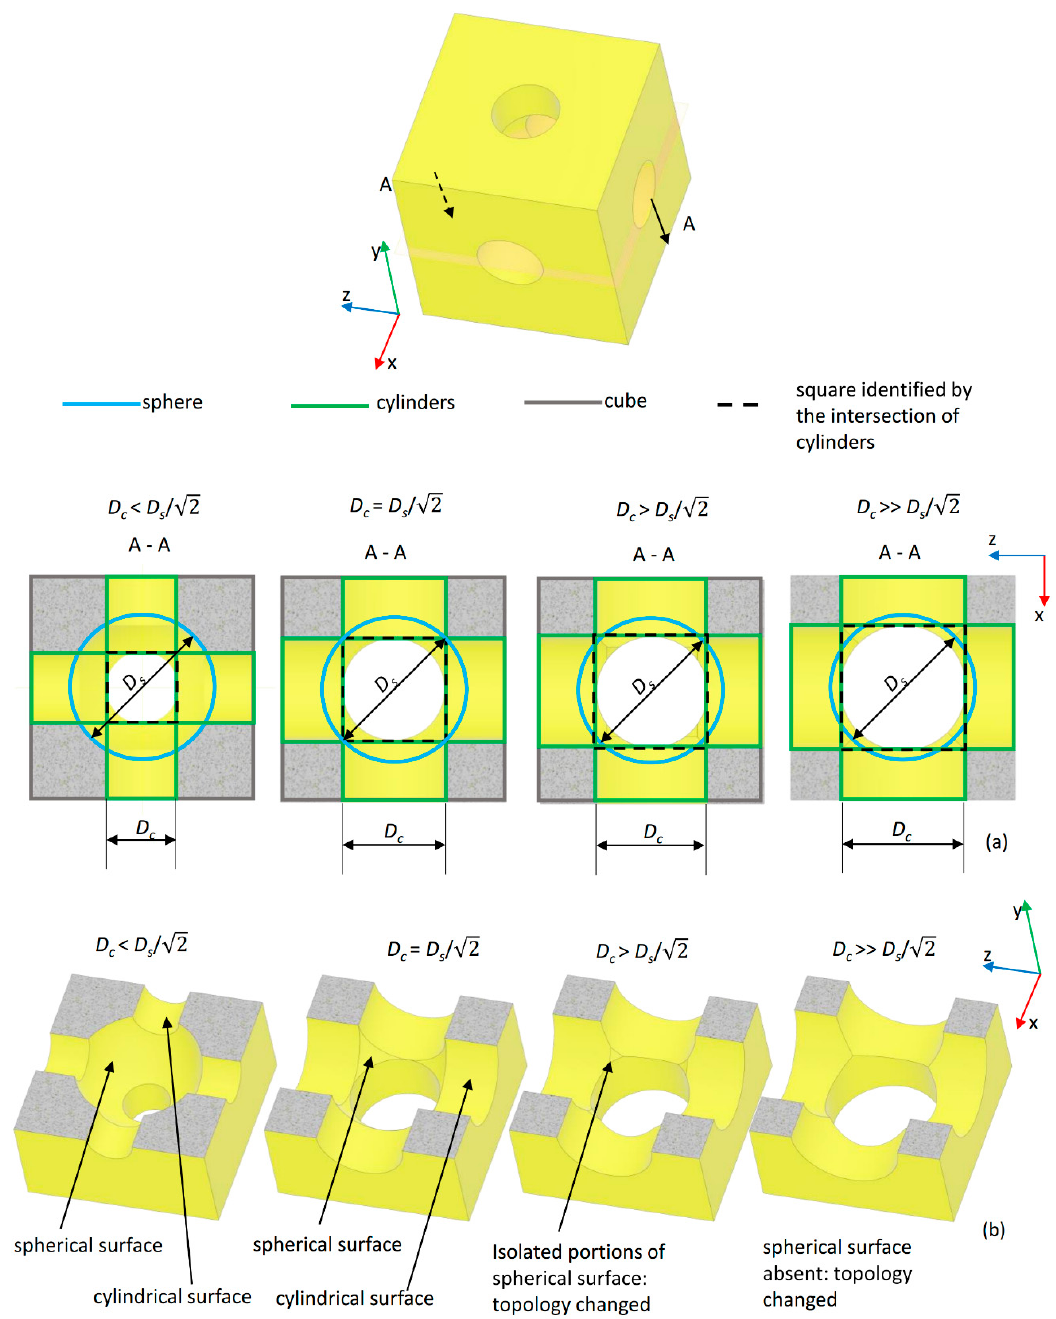
Figure 3. ( a ) Section views—in the plane x–z—of the scaffold unit cell (topology (S) with indicated edges of the primitives (cube, cylinders, and sphere) utilized. When the square obtained by the intersection of the cylinders touches with its vertices, the spherical edge (in blue), the limit condition D c = D s / √2 is reached. For D c > D s / √2 , the topology of the unit cell changes. ( b ) Section views—in the three-dimensional space—of the unit cell obtained for different values of D s and D c .